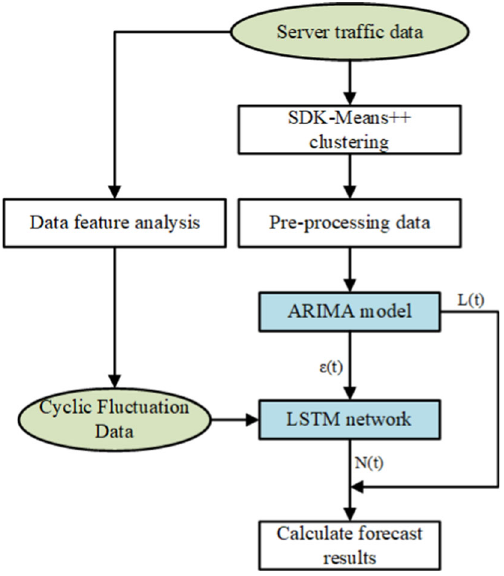
Fig. 7 The structure of the ARIMA-LSTM-CF hybrid